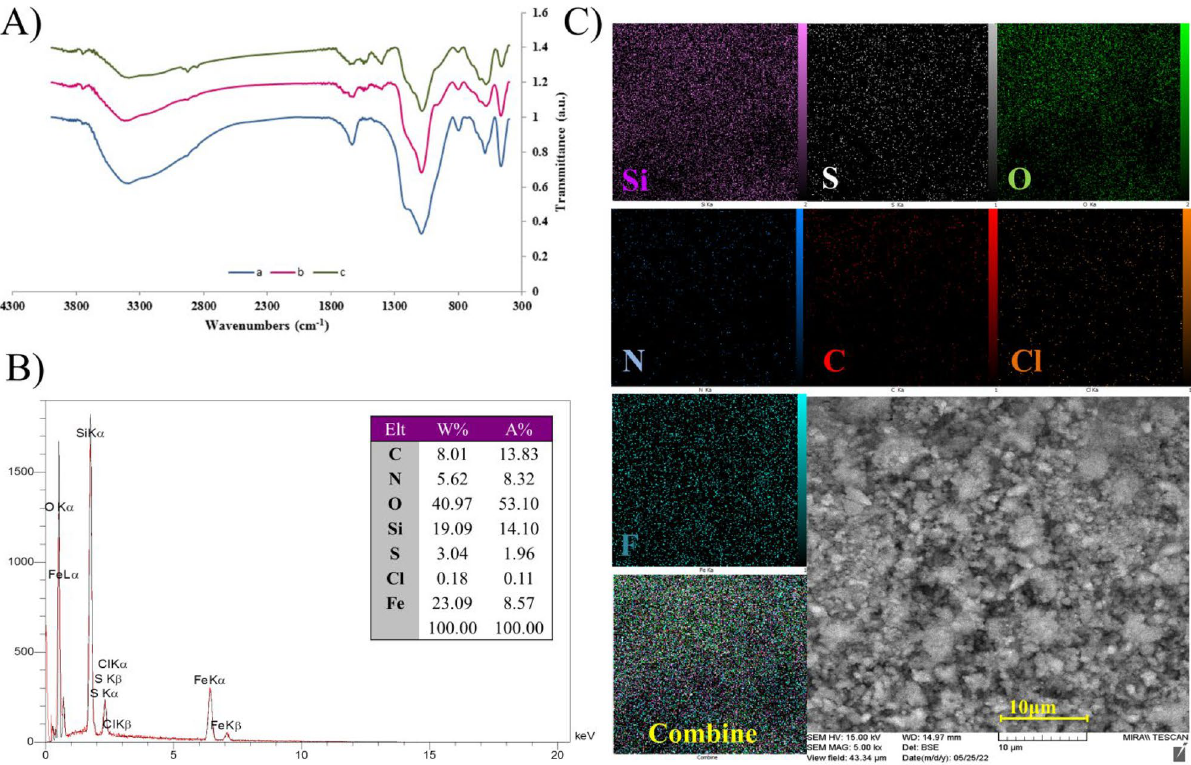
Figure 4. ( A ) The FT-IR spectra of (a) n-Fe 3 O 4 @SiO 2 -TA-SO 3 H IL, (b) n-Fe 3 O 4 @SiO 2 -TA-SO 3 H IL after one time reusing in the reaction, (c) n-Fe 3 O 4 @SiO 2 -TA-SO 3 H IL after eight times reusing in the reaction; ( B ) The EDX analysis of reused n-Fe 3 O 4 @SiO 2 -TA-SO 3 H IL; ( C ) The elemental mapping analysis of reused n-Fe 3 O 4 @ SiO 2 -TA-SO 3 H